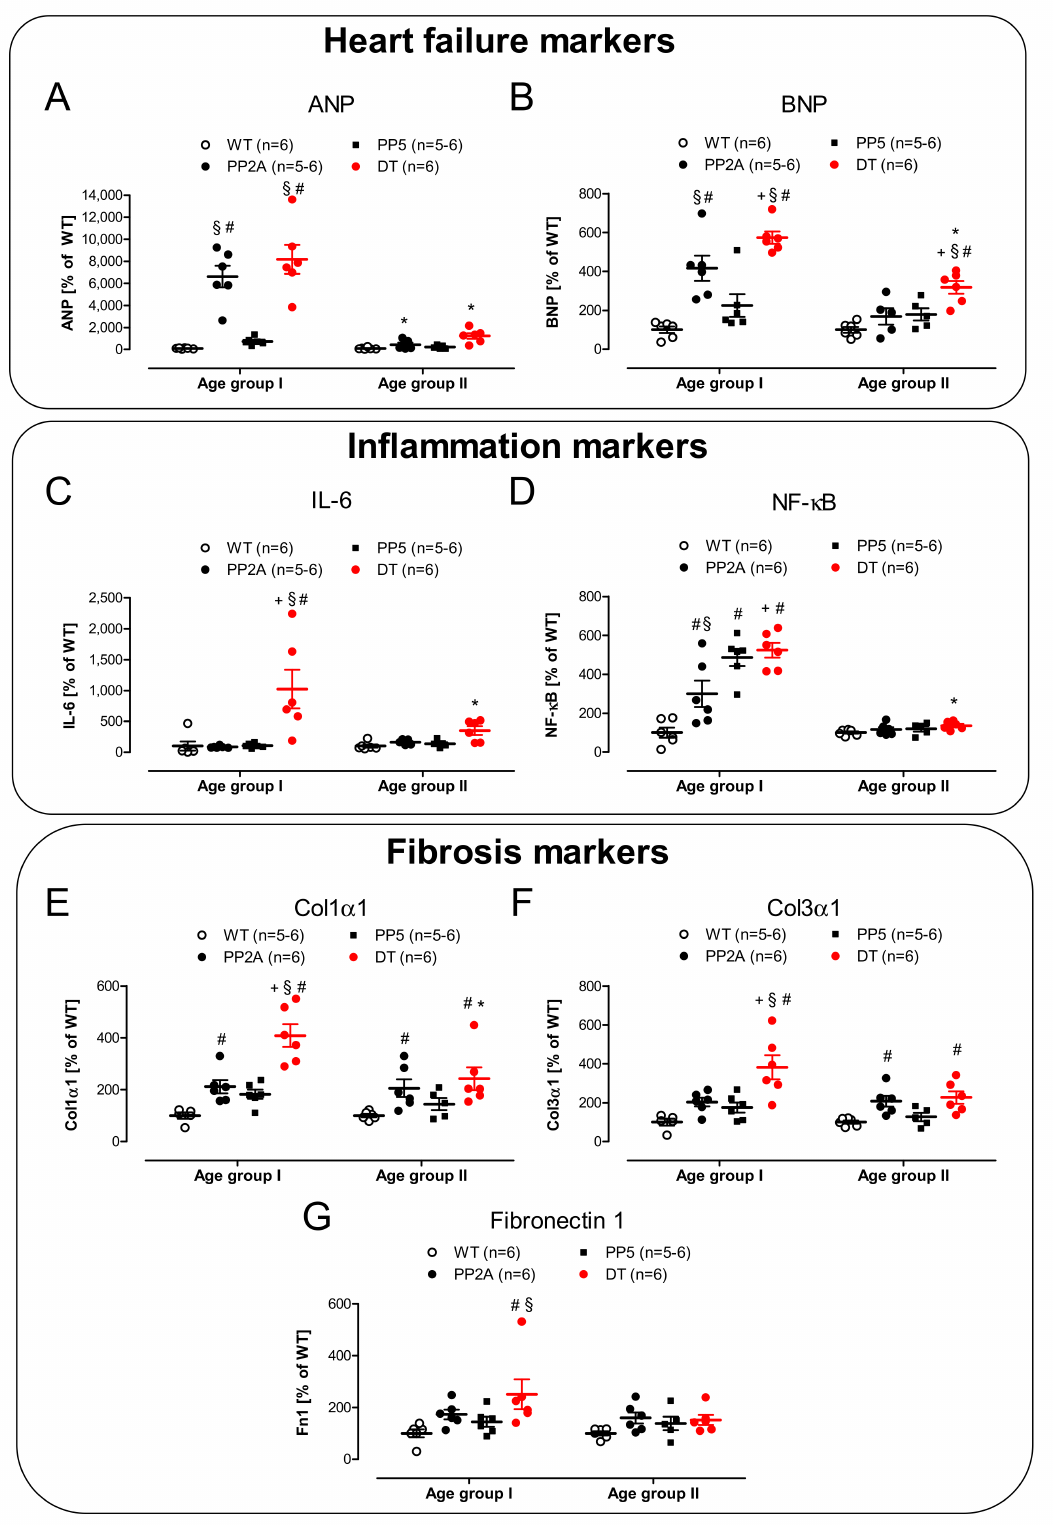
Figure 9. 2 − ∆ CT -plot of cardiac mRNA density of markers of heart failure, inflammation and fibrosis in young (age group I) and middle-age (age group II) mice. ( A ): atrial natriuretic peptide (ANP); ( B ): B-type natriuretic peptide (BNP); ( C ): interleukine-6 (IL-6); ( D ): Nuclear factor kappa B (NF- κ B); ( E ): collagen type I, alpha 1 (Col1 α 1); ( F ): collagen type 3, alpha 1 (Col3 α 1); ( G ); fibronectin 1 (Fn1); # p < 0.05 vs. WT; + p < 0.05 vs. PP2A; § p < 0.05 vs. PP5; * p < 0.05 vs. young; n =